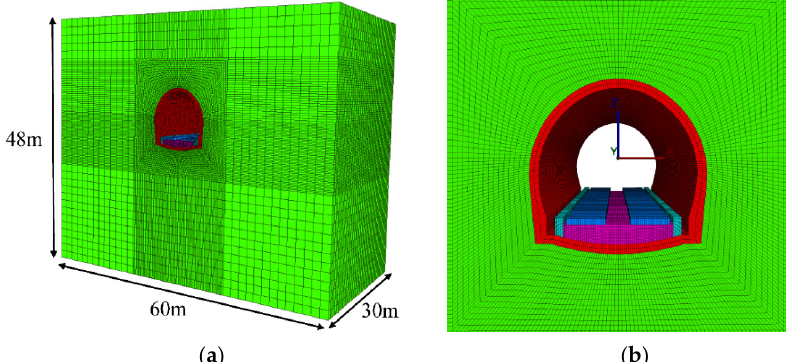
Figure 4. Numerical computation model: ( a ) Overall computational model; ( b ) Local enlarged drawing.